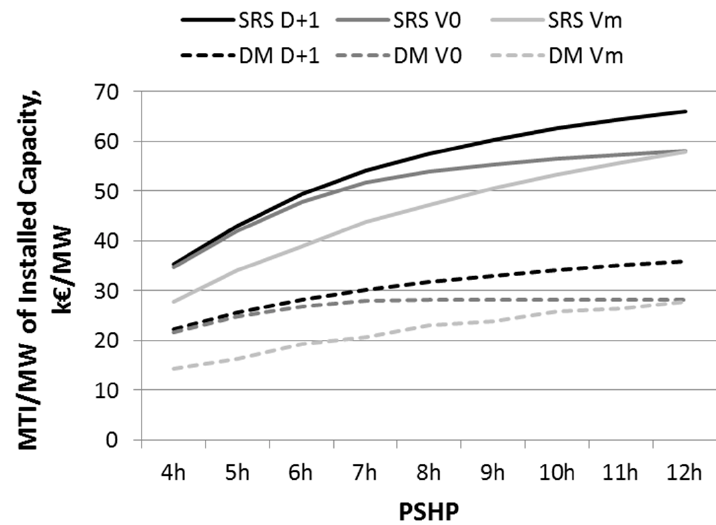
Figure 4. Annual maximum theoretical income (MTI) per MW of the installed capacity in generating mode, of each PSHP participating in the DM and the SRS (solid lines) and only in the DM (dashed lines).